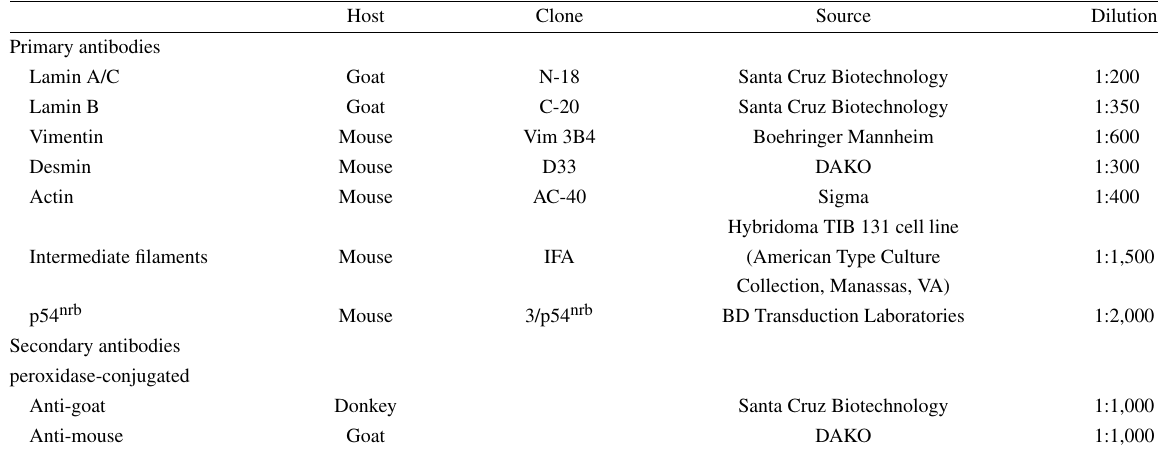
Specificity of the antibodies used in this